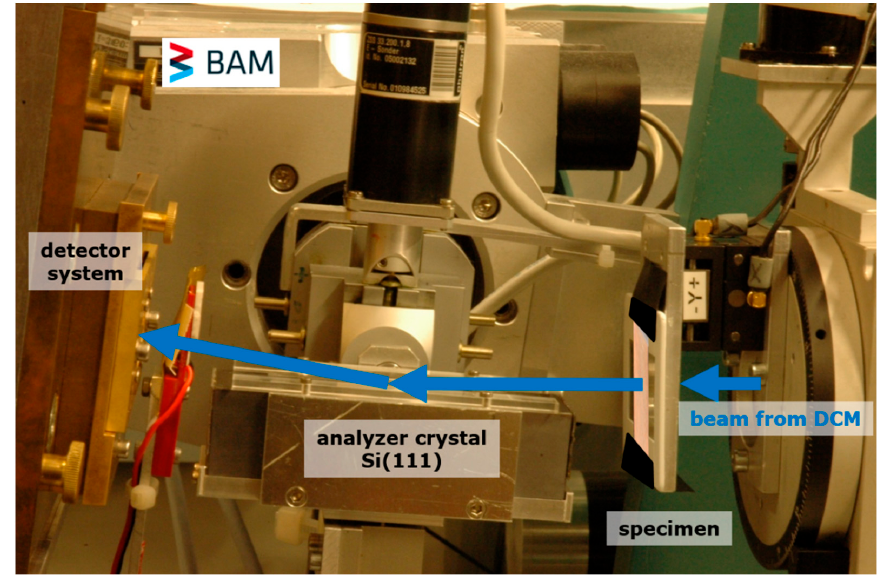
Figure 1. Experimental set up of the X-ray refraction station at BAMline. The specimens were mounted in a slide frame shown on the right. The scattering plane of the Si(111) crystal lies in the image